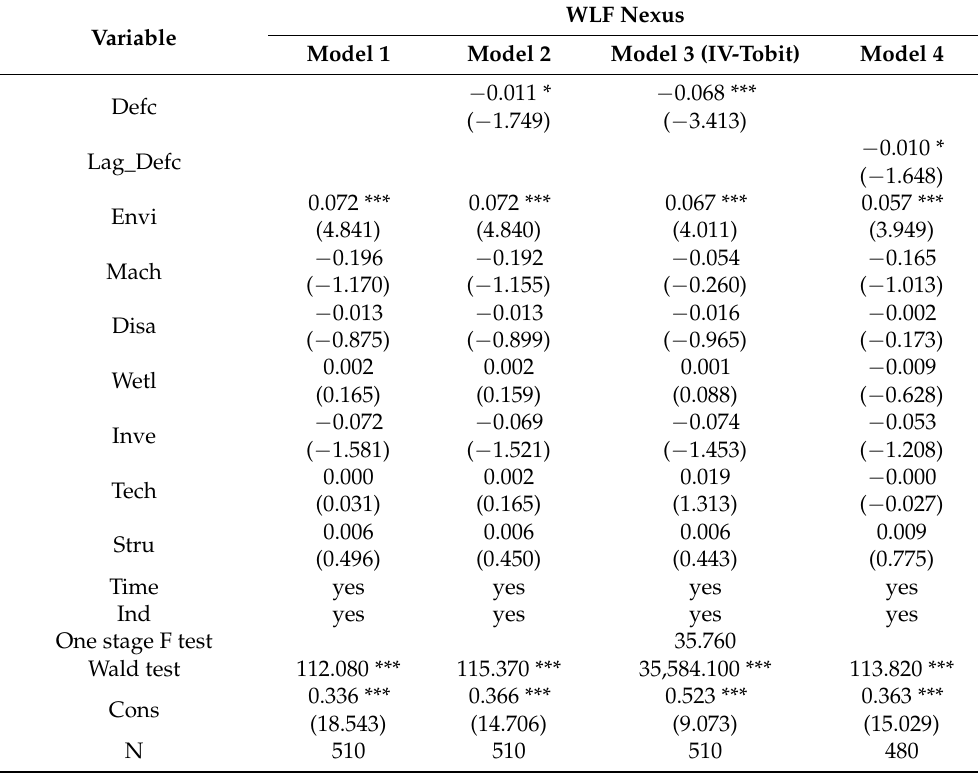
Table 3. Regression results of decentralized food crop cultivation affecting the WLF nexus. WLF Nexus Variable Model